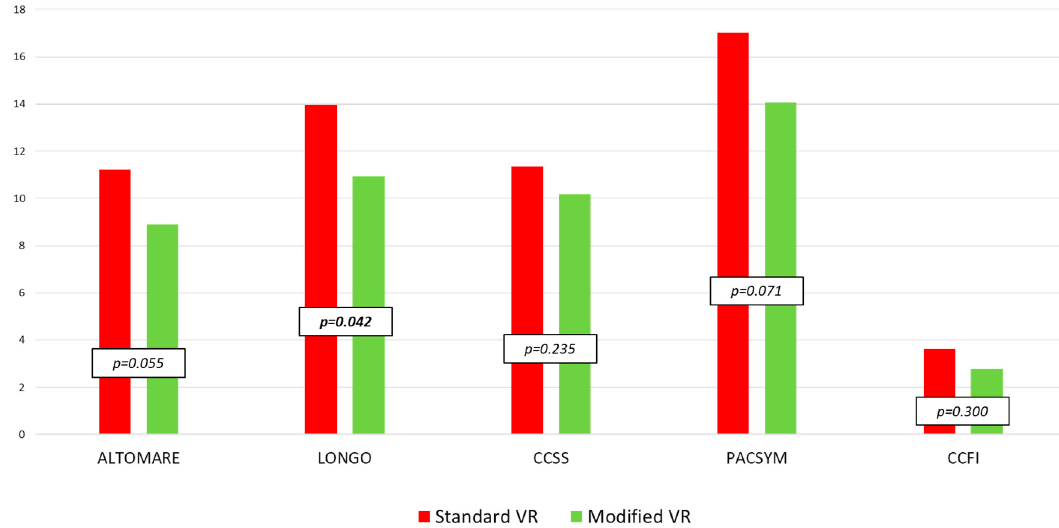
Figure 4. Comparison between postoperative values of clinical scores in patients who underwent standard vs. modified ventral rectopexy (Mann–Whitney U test). Altomare = Altomare score; Longo = Longo score; CCSS = Cleveland Clinic Constipation Scoring System; PACSYM = Patient